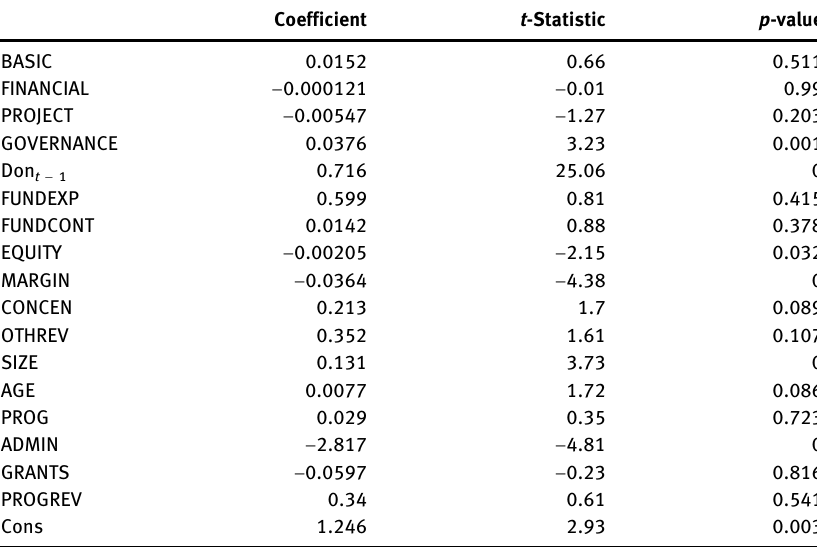
Table  : Baseline regression